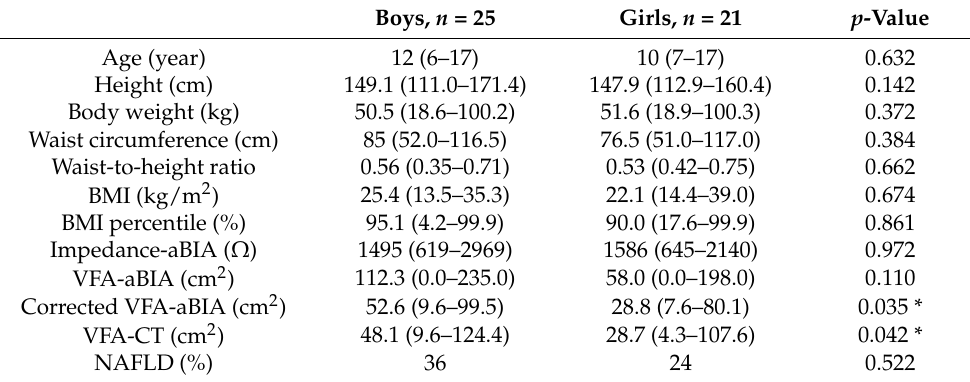
Figure 1. Flowchart of the study. Table 1. Characteristics of boys and girls.